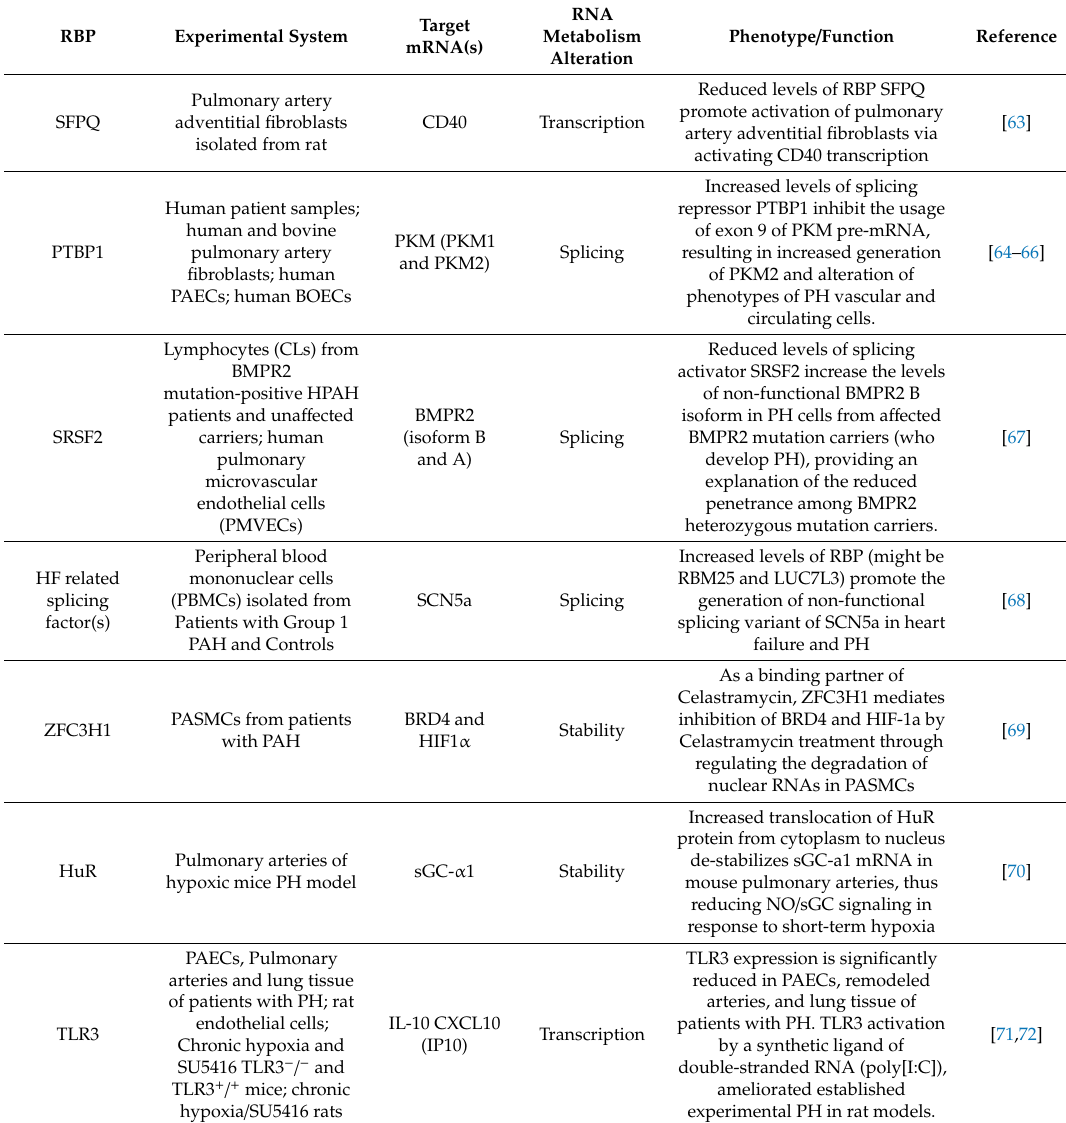
Table 1. Role of RBPS in pulmonary